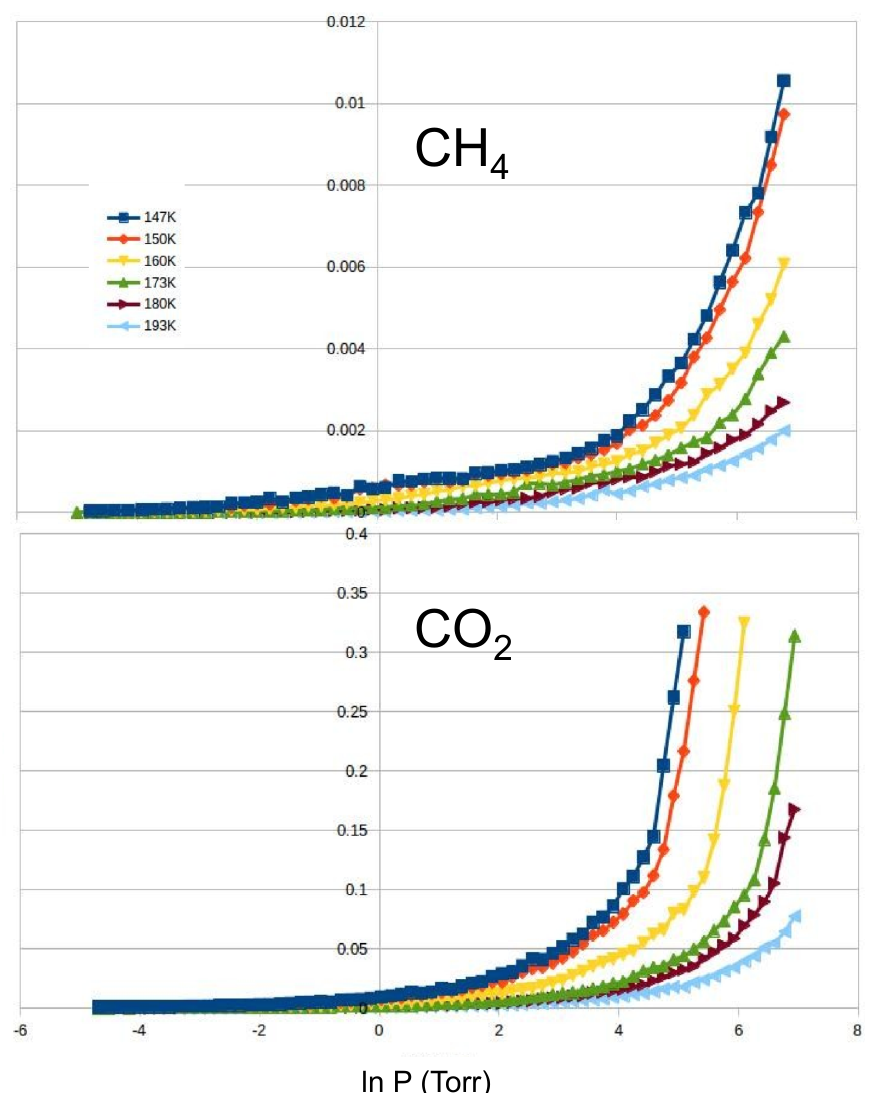
Figure 7. Adsorption isotherms (in arbitrary units) of methane ( top ) and carbon dioxide ( bottom ) at temperatures of 147, 150, 160, 173, 180 and 193 K from left to